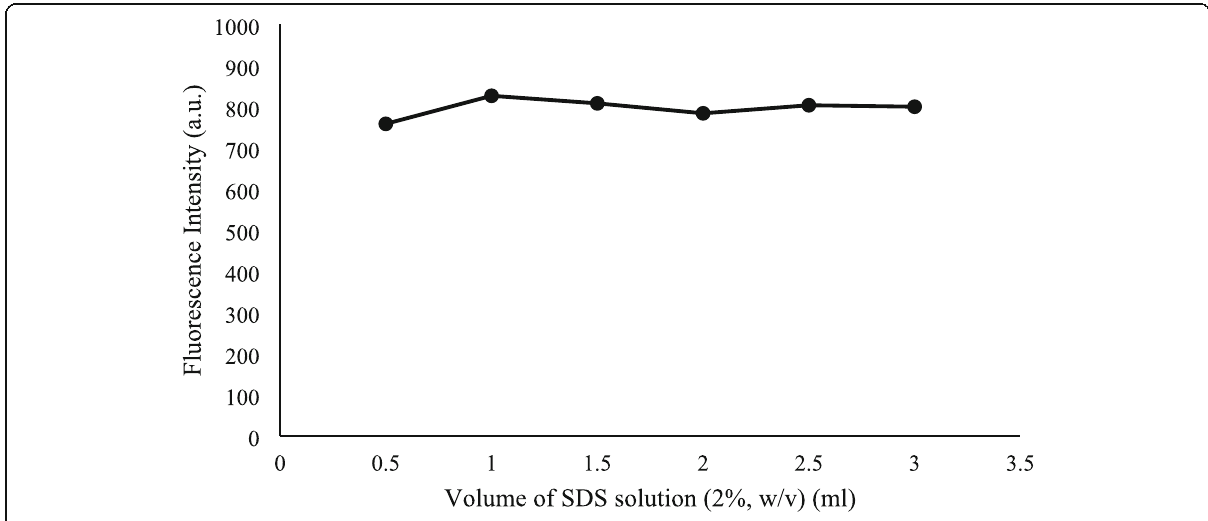
Fig. 6 Effect of SDS solution volume on native fluorescence